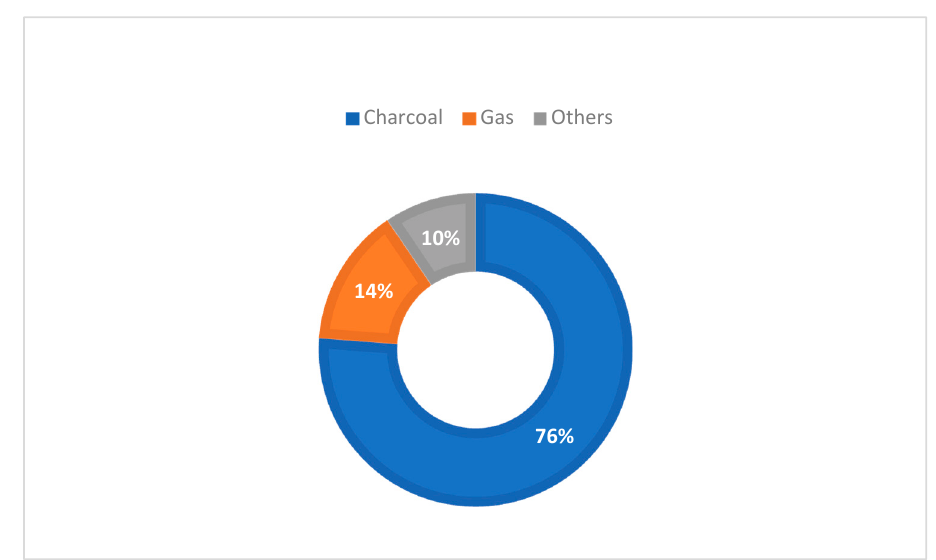
Figure 3. Alternative energy sources.